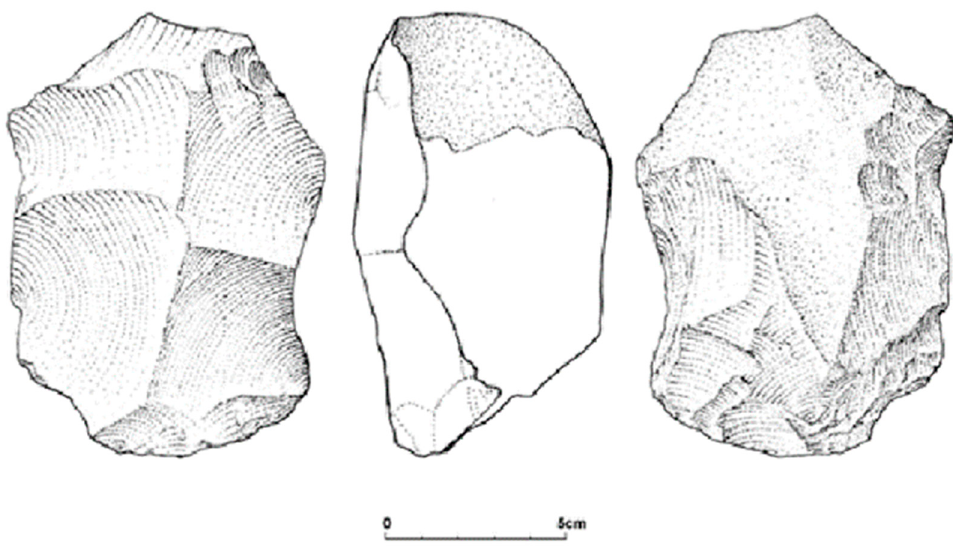
Figure 8. Münster-Sarmsheim. Typical Acheulian core, found on the outcropping terrace nearby the gravel pit. (After Fiedler and Hochgesand 1980).